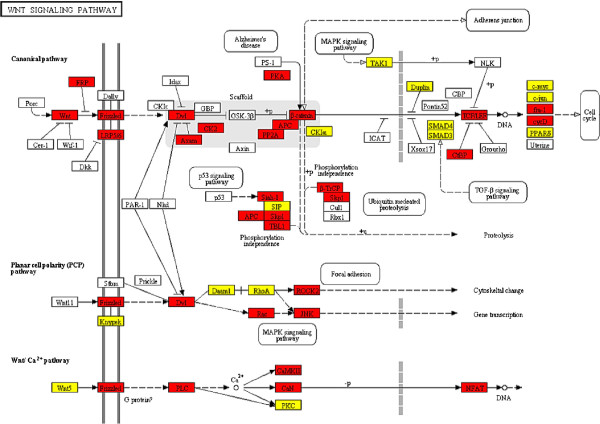
WNT signaling pathway. WNT signaling pathway: 32 targets of 5 miRNAs are involved in the pathway (red boxes). 14 mRNAs are targeted by the remaining miRNAs are colored in yellow; and 23 mRNAs involved in the pathway were excluded from the BayMiR target list since their expression variabilities across arrays were very low (white boxes). The miRNA family IDs: miR-518a-5p/520d-5p/524-5p,miR-556-3p,miR-4514/4692,miR-548aeajamx,miR-135ab/135a-5p;.